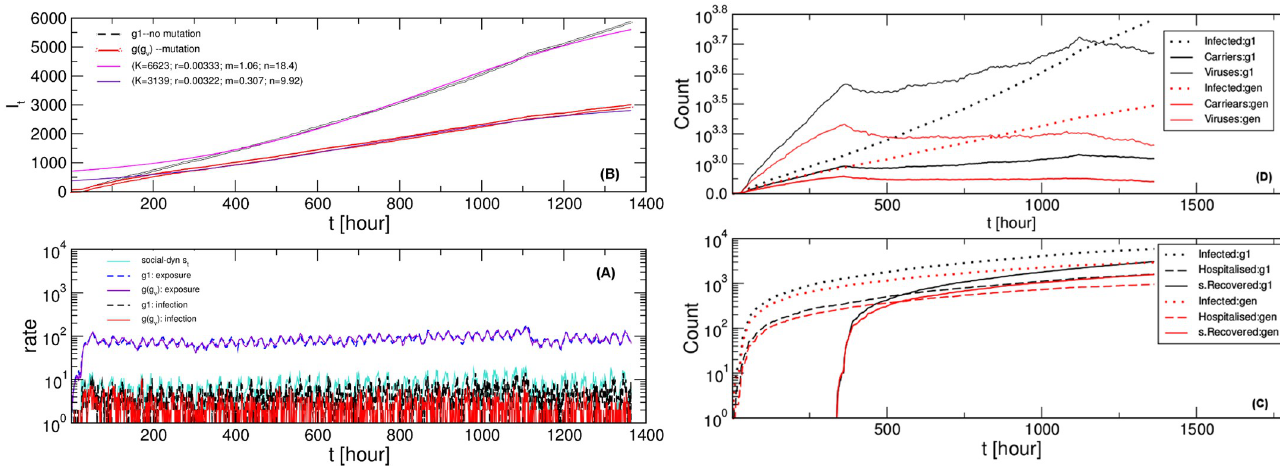
Fig 3. Comparative simulations for virus mutations (“gen”) and without mutations (“g1”). Results are for the same social dynamics–time series s panel (A). Time fluctuations of the number of exposed agents and the number of infected agents per hour, panel (A), and the corresponding infectious curves–the cumulative number of infected agents, panel (B). Fits according to the logistic function (parameters shown in the legend). The cumulative number of spontaneously recovered and hospitalised agents are shown in panel (C) and the respective fluctuation of the number of active carriers and active viruses, in panel (D). In panels (C) and (D), the infection curves from panel (A) are shown by dotted lines, for comparison.